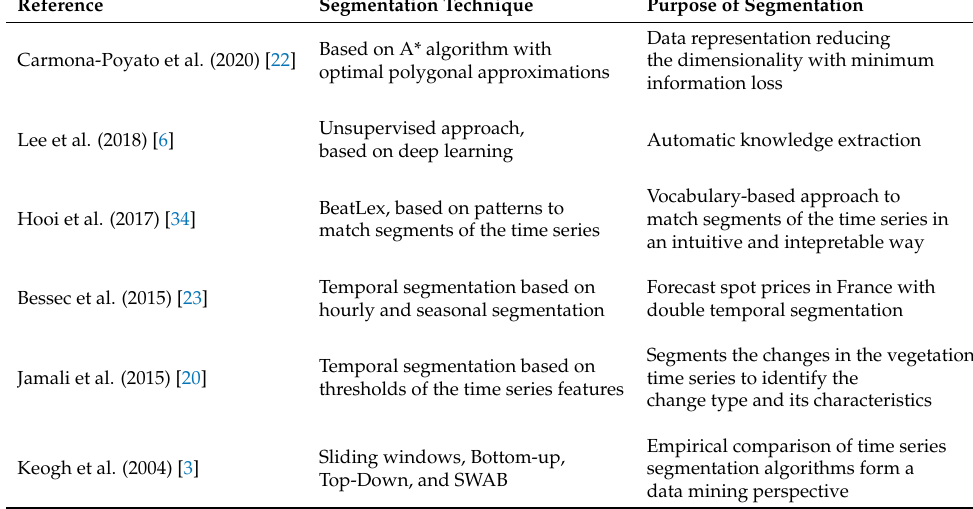
Table 1. Comparison of time series segmentation techniques in the